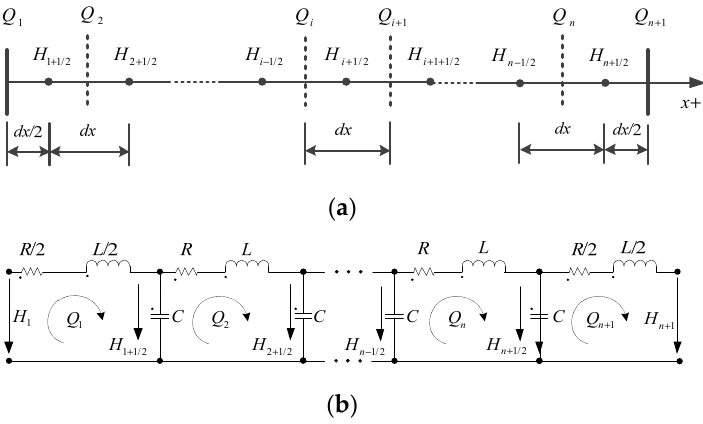
Figure 2. Diagram of space discretization in the pipe: ( a ) state variable location definition; ( b ) equivalent scheme of the system of ( a ).